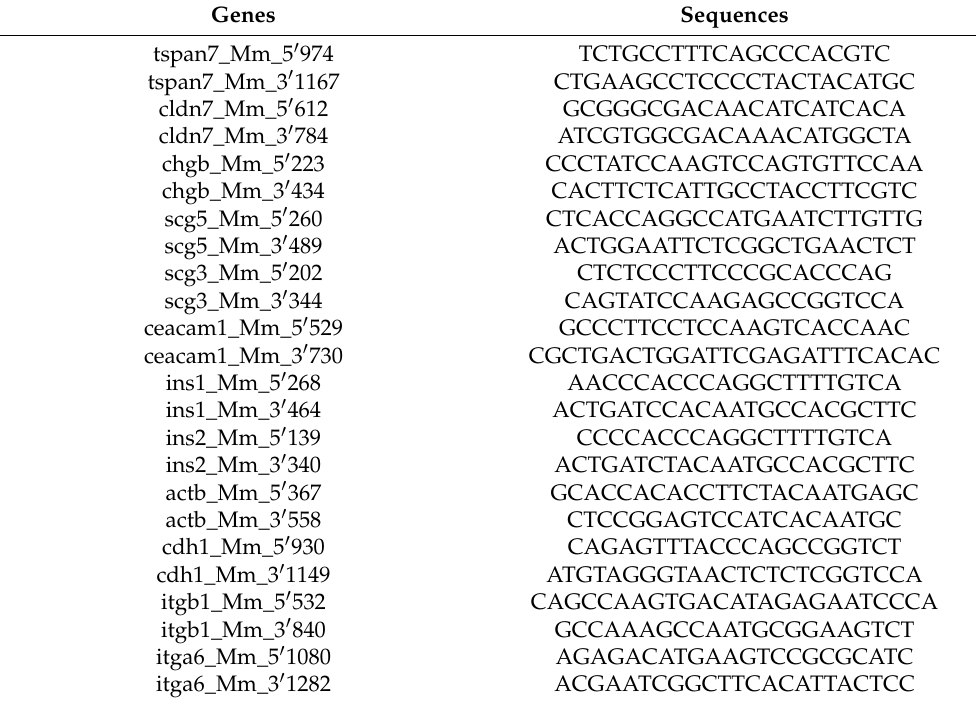
Table 1. PCR primers used for gene expression analysis. Genes